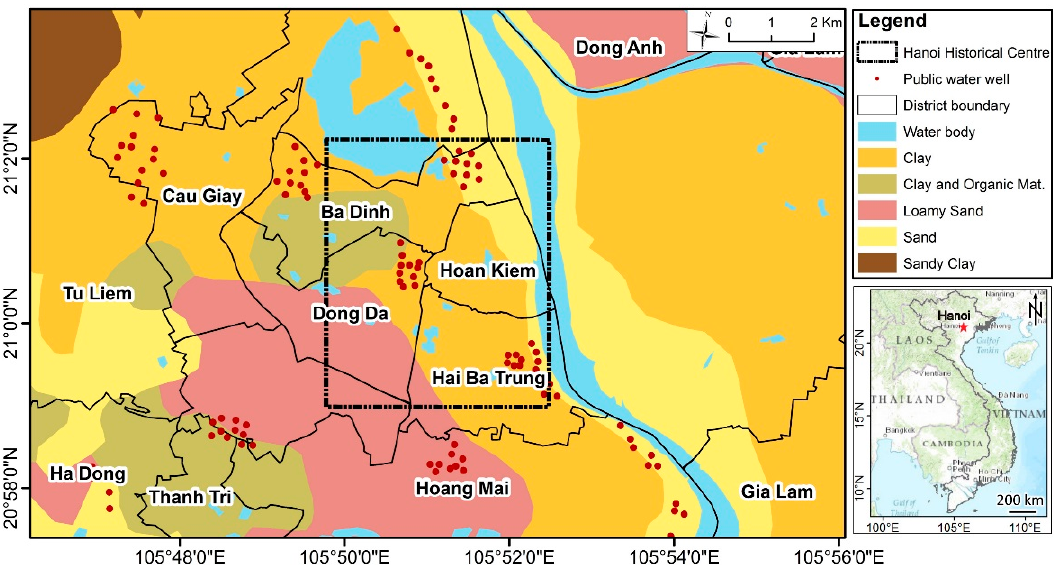
Figure 1. Surface geology map (after Nguyen [11]) and location of the Historical Centre of Hanoi.